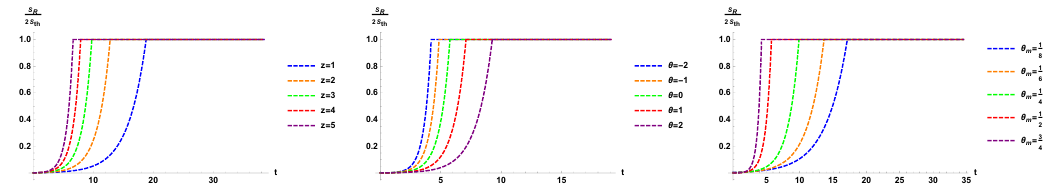
Figure 5 . Entropy of Hawking radiation S R when the matter is described by a HV QFT d +2 with for some values of z . ( Middle ) θ m 6 = 0 as a function of t : ( Left ) when d = 2 , θ = 1 and θ m = 1 3 when d = 3 , z = 2 and θ = 1 for different values of θ . ( Right ) when d = 3 , z = 1 and θ = − 1 for m 2 some values of θ . Here we set A = V = r = 1 and G = 0 . 001 . It should be pointed out that m d h N,r we omit the correction of order O ( G 0 ) in eq. (4.44). N,r